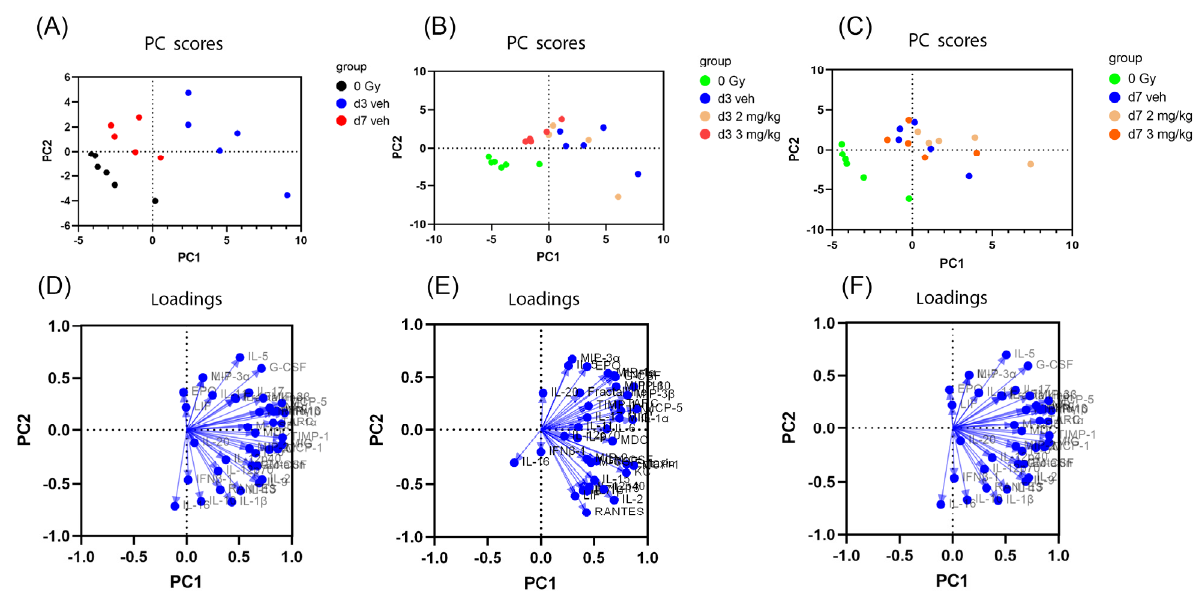
Figure 2. PCA analysis of serum cytokines in CD2F1 mice with irradiation and/or rhIL-18BP treatment. ( A ) PC score plot of non-irradiated mice with d3 and d7 irradiated vehicle treatment mice. ( B ) PC score plot of non-irradiated mice, and d3 irradiated mice (treated with vehicle or 2 or 3 mg/kg rhIL-18BP). ( C ) PC score plot of non-irradiated mice, and d7 irradiated mice (treated with vehicle or 2 or 3 mg/kg rhIL-18BP). ( D ), loading score plot of ( A ). ( E ), loading score plot of ( B ). ( F ), loading score plot of ( C ).